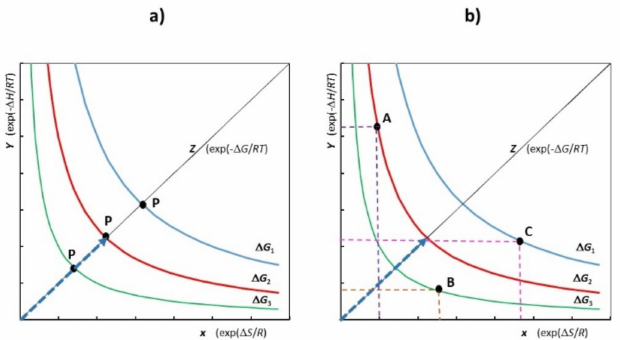
Figure 1. Hyperbolic partition functions in probability space. ( a ) exp( − ∆ Γ /T ) = exp( − ∆ G · (cos 45 ◦ )/ RT ); ( b ) exp( − ∆ G A / RT ) = exp( − ∆ H A / RT ) exp( ∆ S A / R